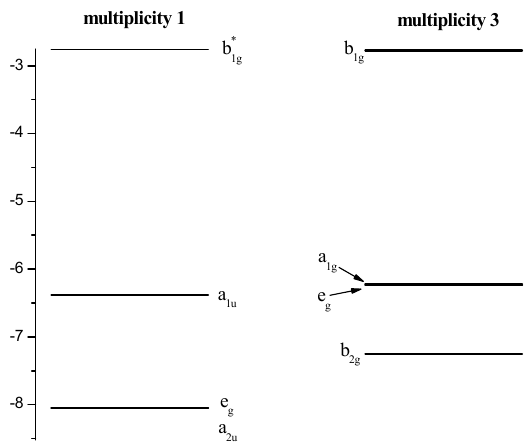
Figure 4. Diagram of the active energies in the CASSCF calculations of the molecular orbitals of NiTTDPz.